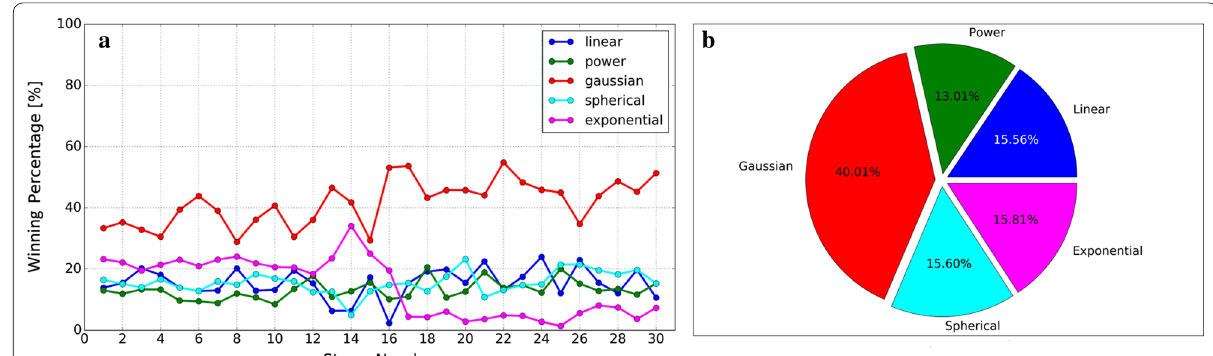
Same as Table 4 but for hm F2